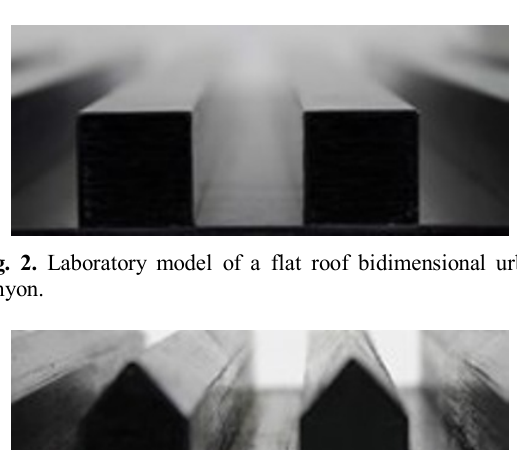
Fig. 1. Example of a real flat roof bidimensional urban canyon in the city of Cagliari (Italy).